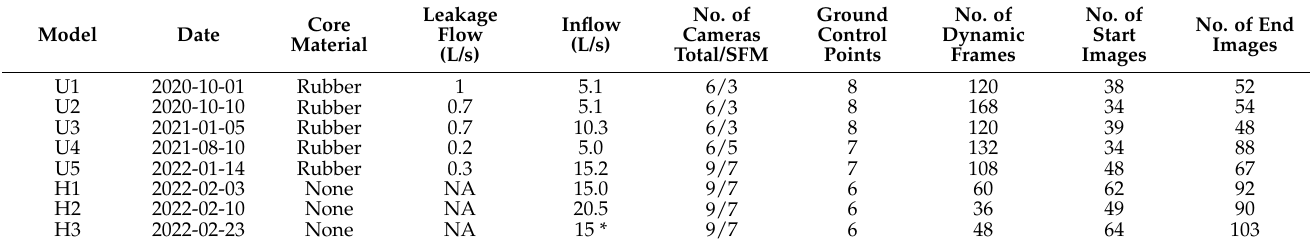
Table 1. Overview of model tests with key parameters.